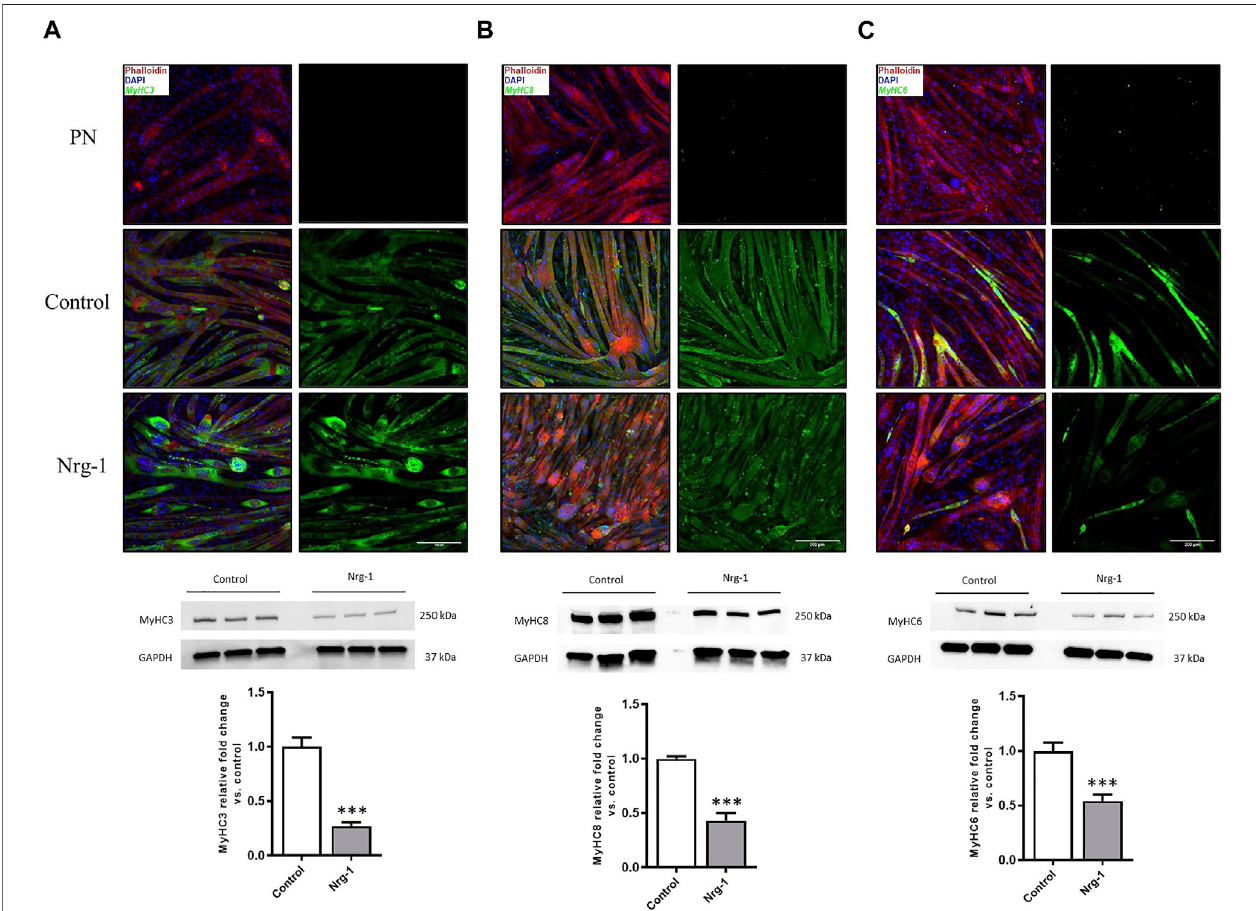
FIGURE5| Decreasedexpressionofputativeintrafusalspeci fi cproteinsfollowingNrg-1treatmentinC2C12myotubes.Immuno fl uorescentimagingsuggestedno clear intrafusal bag myotube preferential expression MyHC3, 8 or 6. Phalloidin (red), DAPI (blue) and MyHC (green). Top to bottom: PN (primary negative), control and Nrg-1 treated representative fl uorescent micrographs (scale bar, 200 µm), western blot representative gels and fi nally MyHC fold change relative to control based on western blots. (A) MyHC3. (B) MyHC8. (C) MyHC6. Western blot lanes represent three biological repeats, n of 3 achieved by repeating on three separate blots, Mean ± SEM, ***, n (cid:1) 3, p <